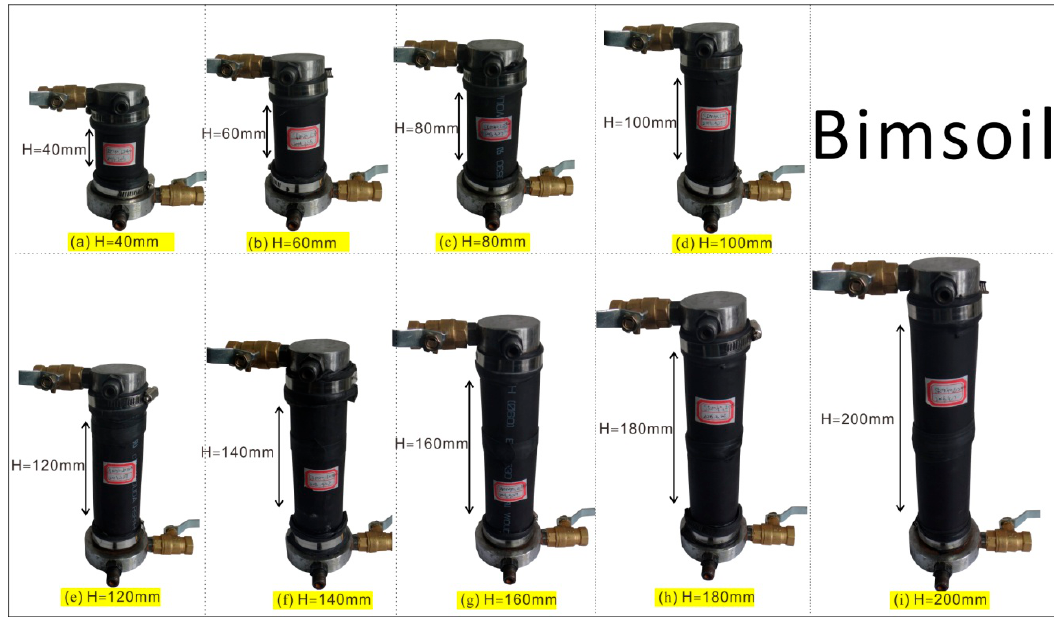
Figure 3. The sample chamber system for bimsoil samples with different height, taking samples with RBP (rock block percentages) of 30% as an example.